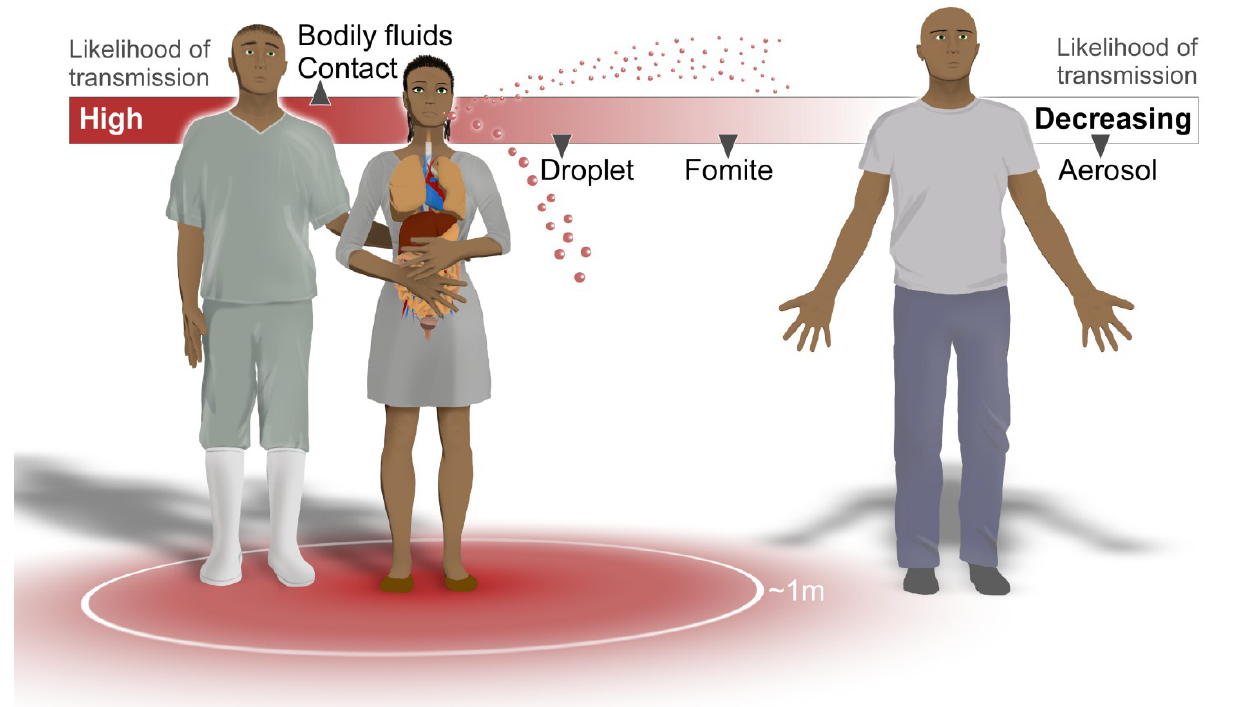
Figure 1. Potential routes of Ebola virus transmission and infection between people. Ebola virus (EBOV) has been isolated from bodily fluids including blood, stool, semen, saliva, and breast milk [6]; contact with these fluids from infected individuals creates a high risk of transmission. These infectious fluids can also be formed into droplets which travel in the air (range unknown, possibly 1 meter) and potentially infect others. EBOV has been detected in dried blood and persists on surfaces, so the possibility of fomite transmission exists. Airborne transmission via small aerosol droplets is unlikely from current EBOV